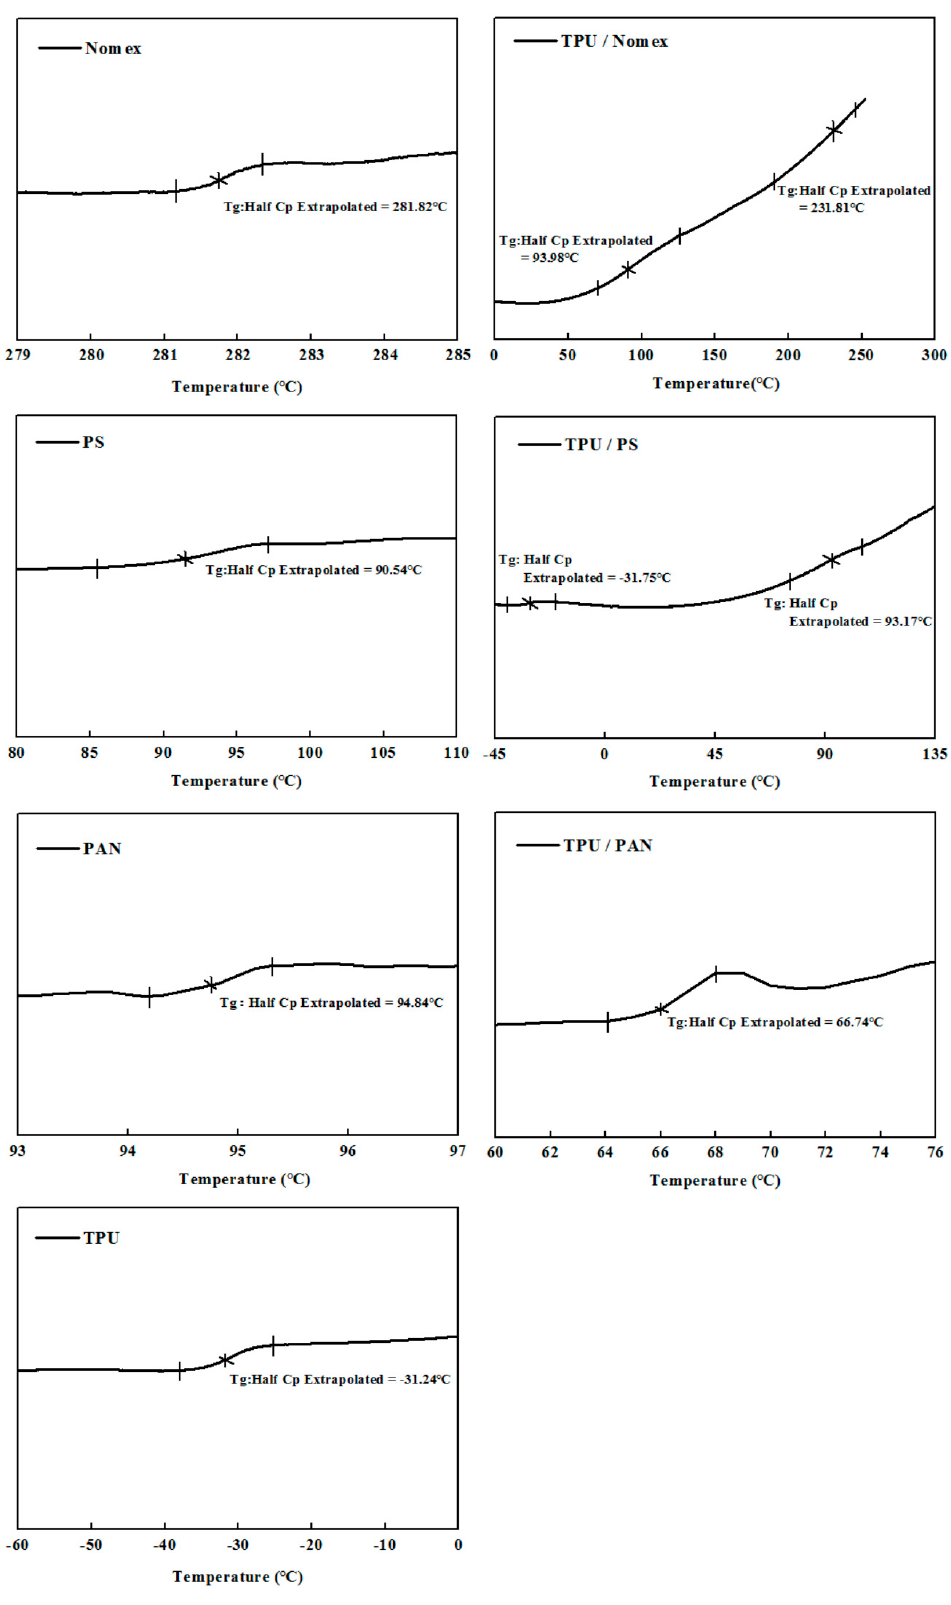
Figure 4. DSC thermograms of the three component systems including the pure polymers and the blends.